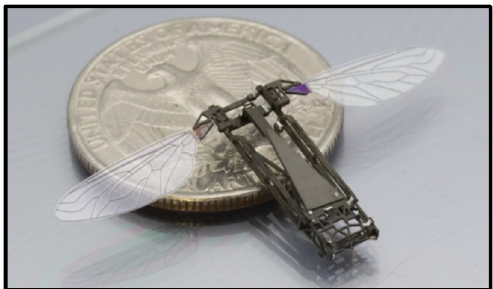
Figure 5. “Robobee,” an FWMAV driven by a new “artificial muscle” material developed by Harvard University.